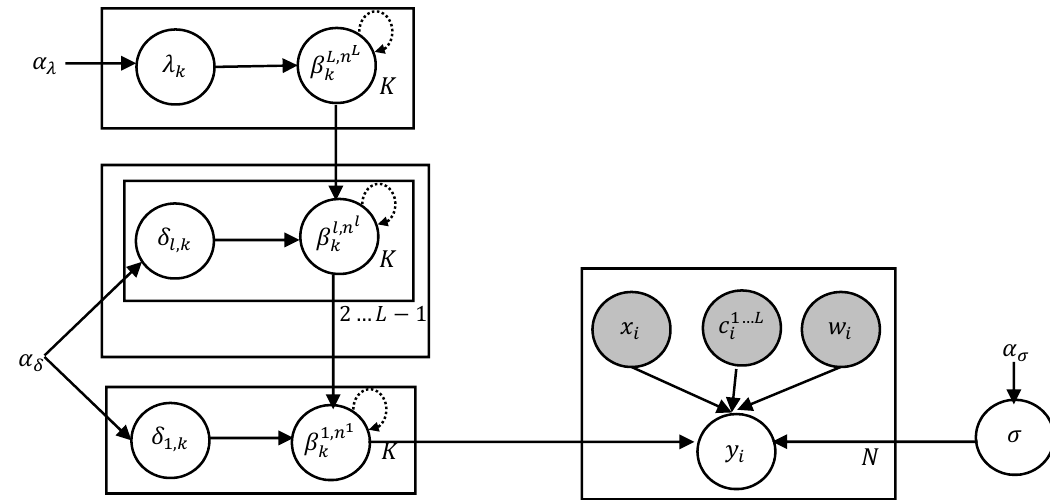
Figure 1. Model overview using plate notation. The response is determined from the input variables and the regression coefficients at the first level. The regression coefficients have dependencies across various levels (to ensure a hierarchical relation) and dependencies with adjacent coefficients (to enforce smoothness and monotonicity). The variance variables and their hyperparameters are shown on the left and right sides.